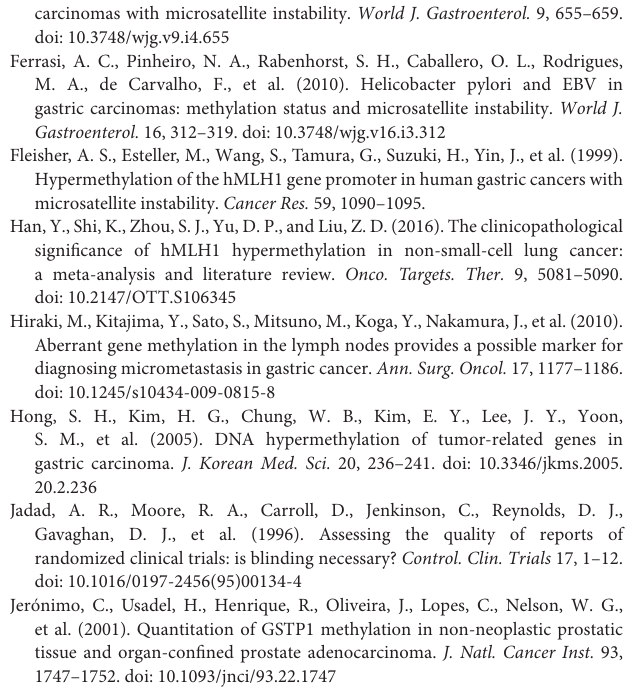
hMLH1 methylation and HP infection or Lauren